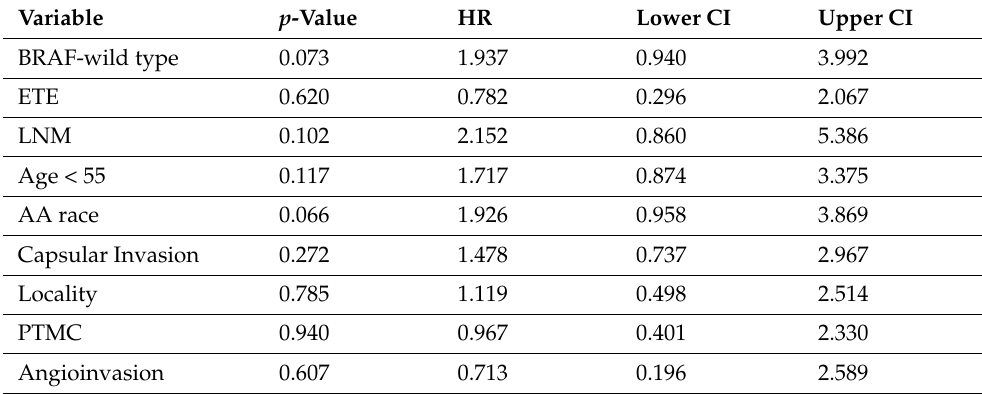
Table 4. Multivariate logistic regression analysis including only PTC patients to determine indepen- dent predictors of